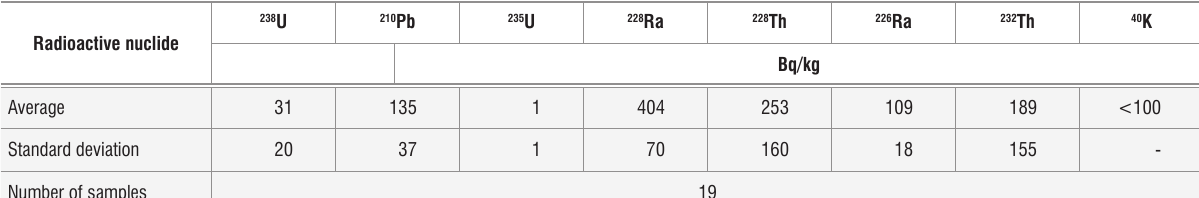
Activity concentrations of radioactive nuclides in the phosphogypsum from the Lowveld region of South Africa 238 U 210 Radioactive nuclide